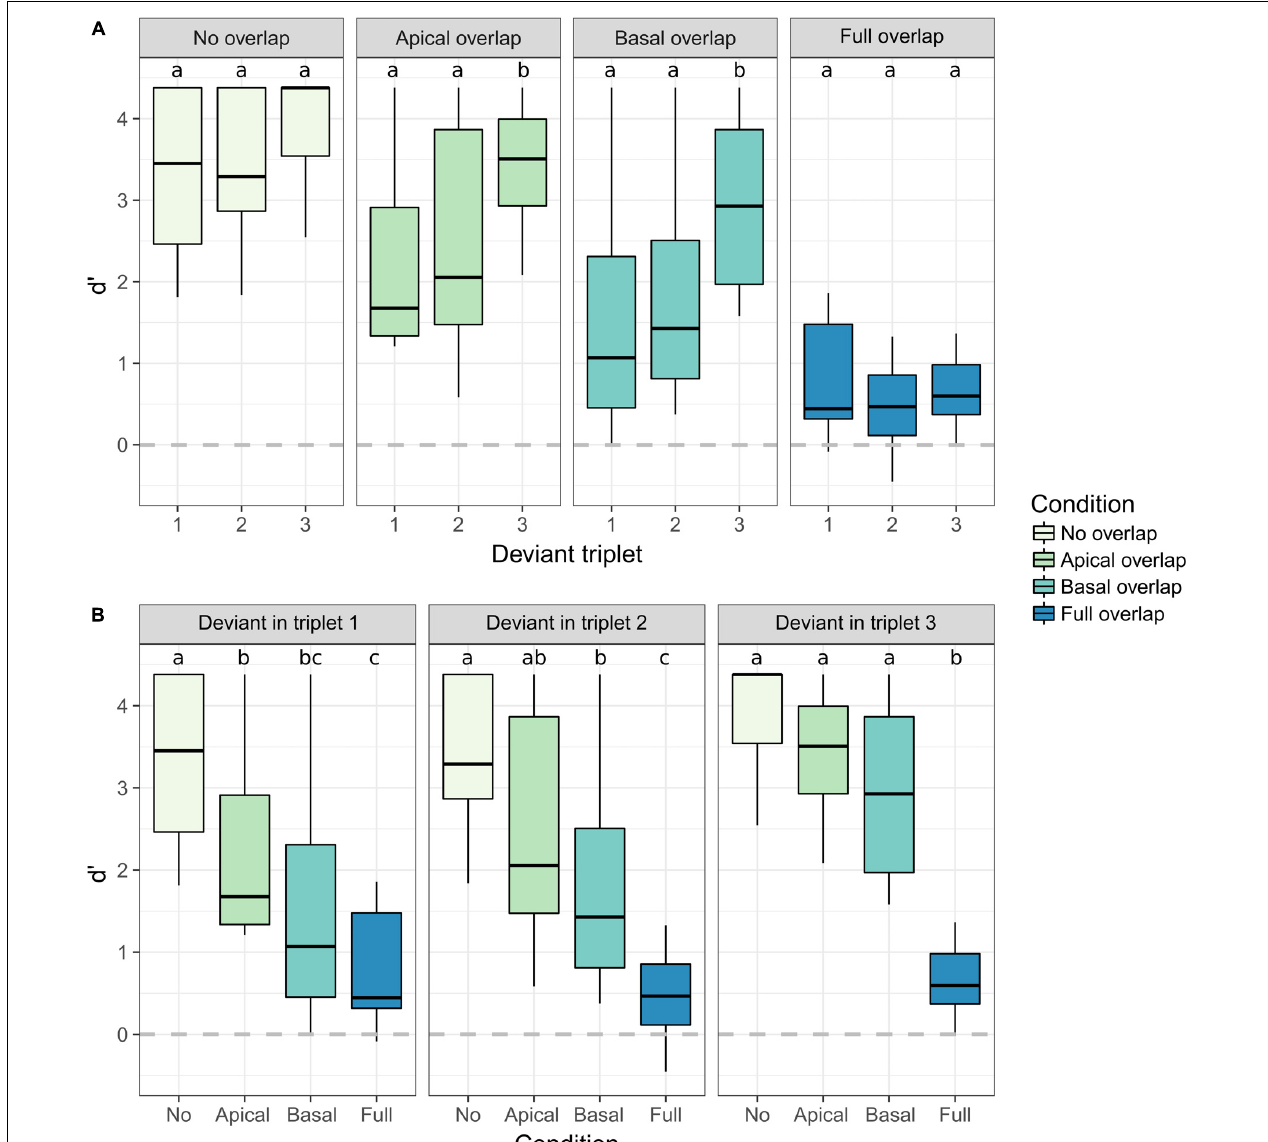
FIGURE 3 | Boxplot of the sensitivity scores (d (cid:48) ) to the deviant triplet for each electrode separation and deviant triplet location. The color of the boxes represents the electrode separation condition. (A) Effect of the deviant triplet for each electrode separation condition. (B) Effect of the electrode separation for each deviant triplet location. Results from the statistical contrasts are indicated with lowercase letters. Conditions sharing one or more letters are not significantly different (significance level α =